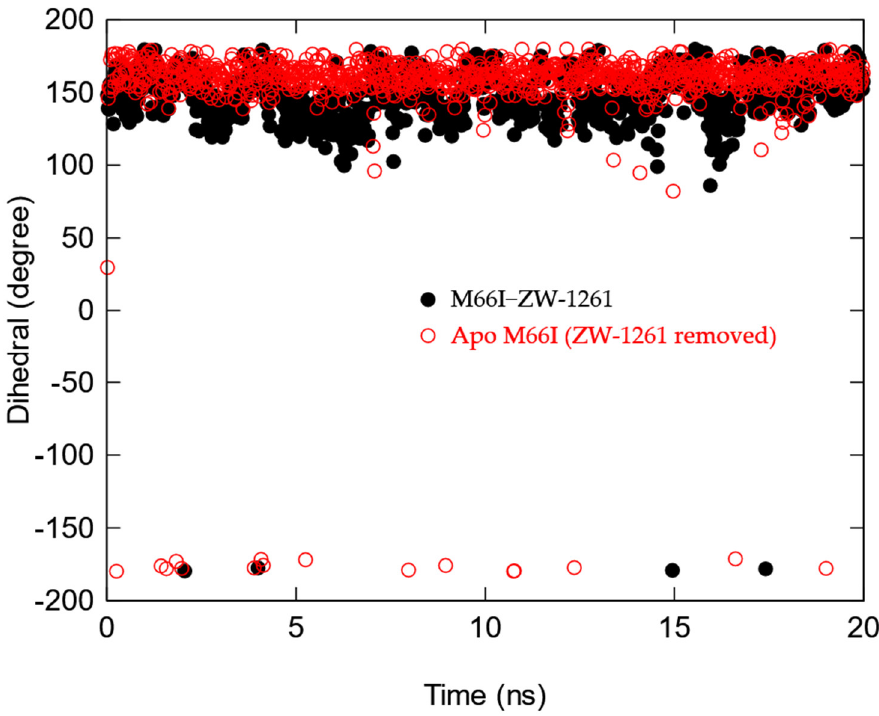
Figure 7. Time course of the χ 1 torsion in the side chain of I66 of the M66I CA mutant after the ZW-1261 is manually removed (red), M66I−ZW-1261complex (black).